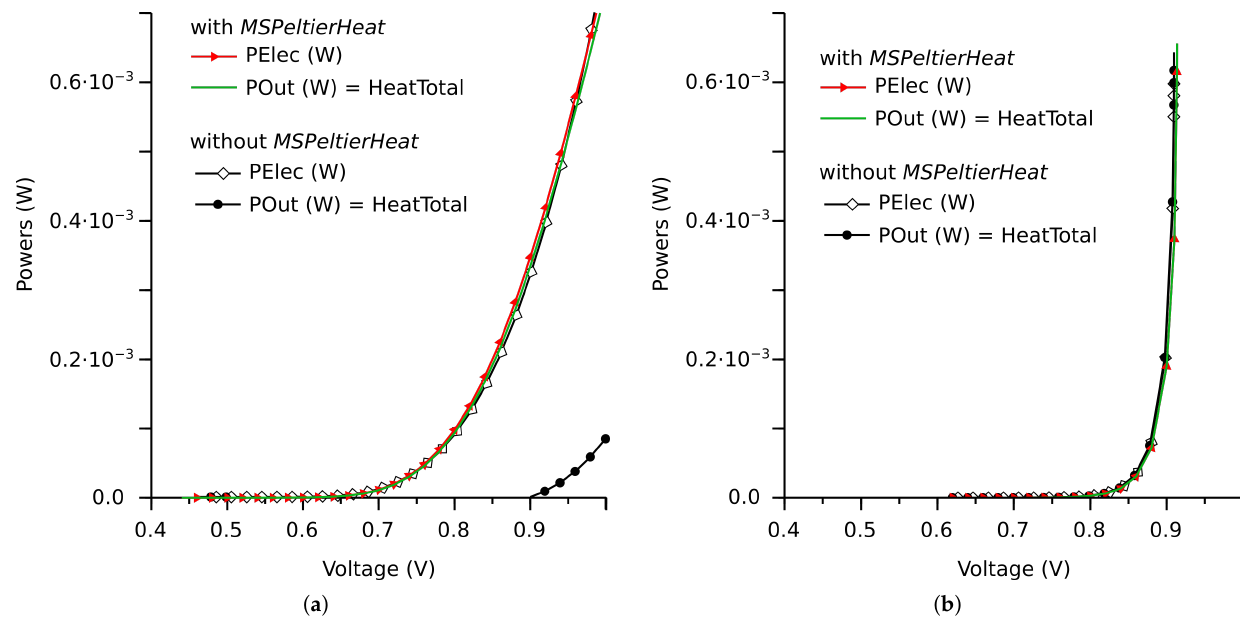
Figure 5. Powers calculated with and without the MSPeltierHeat model for ( a ) geometry S1, ( b ) geometry S2. The structure parameters were C = 0.5 µ m, P +